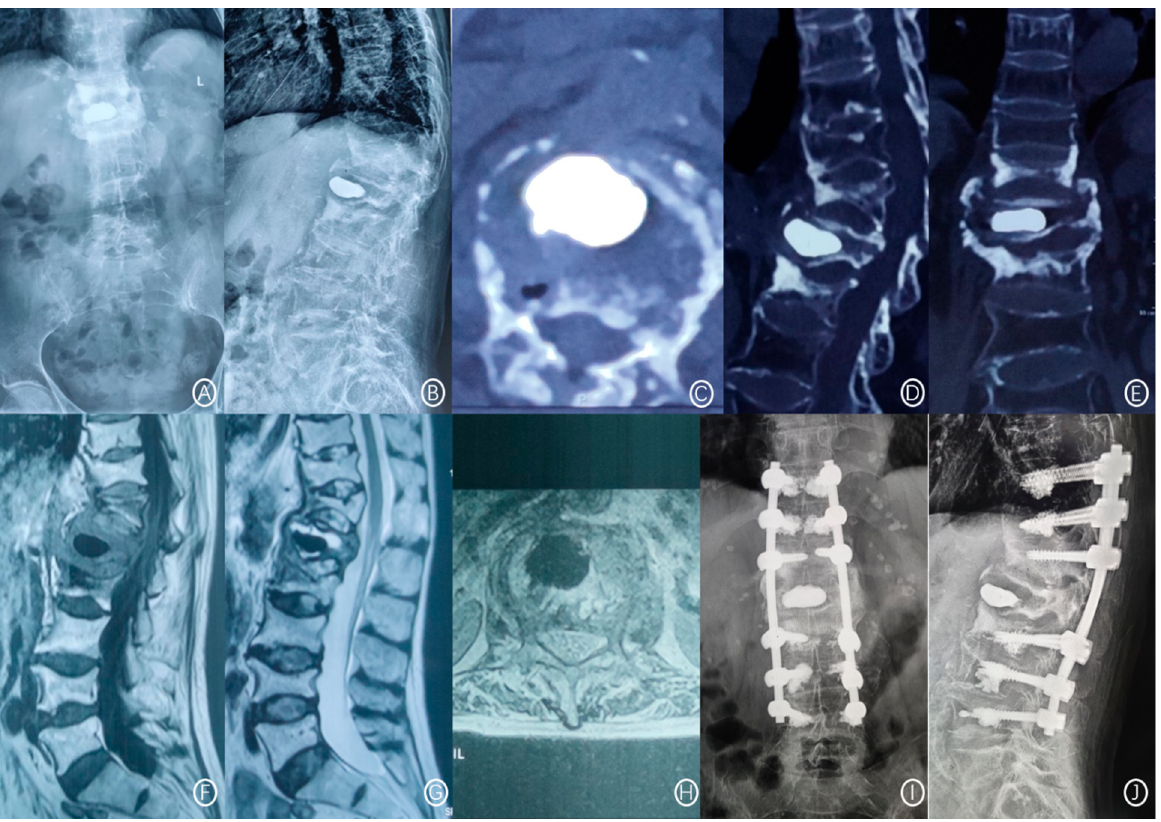
Figure 2. A 71-year-old female patient had recurrent low back pain and limited movement 3 years after L 1 vertebroplasty. ( A , B ): Lumbar positive and lateral X-ray films scanning at 36 months after PVP showed L 1 vertebral cement displacement and T 12 vertebral compression fracture. ( C – E ): CT